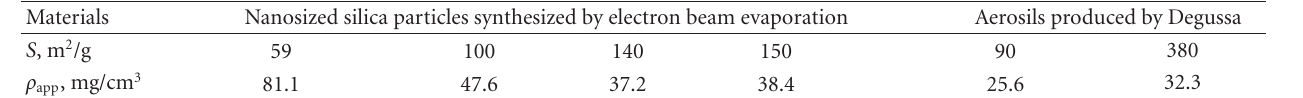
Table 2: Apparent density of the studied materials.